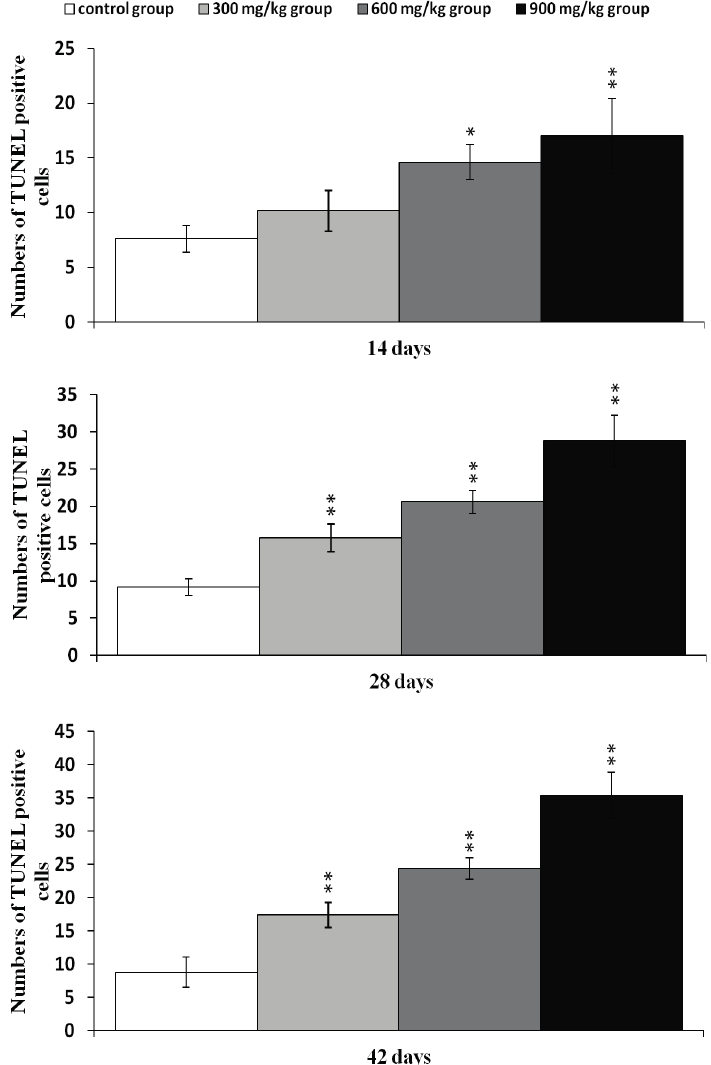
Figure 5. Changes of TUNEL-positive cells at 14, 28 and 42 days. Data are presented with the mean ± standard deviation ( n = 5 × 5); * p < 0.05, compared with the control group; ** p < 0.01, compared with the control